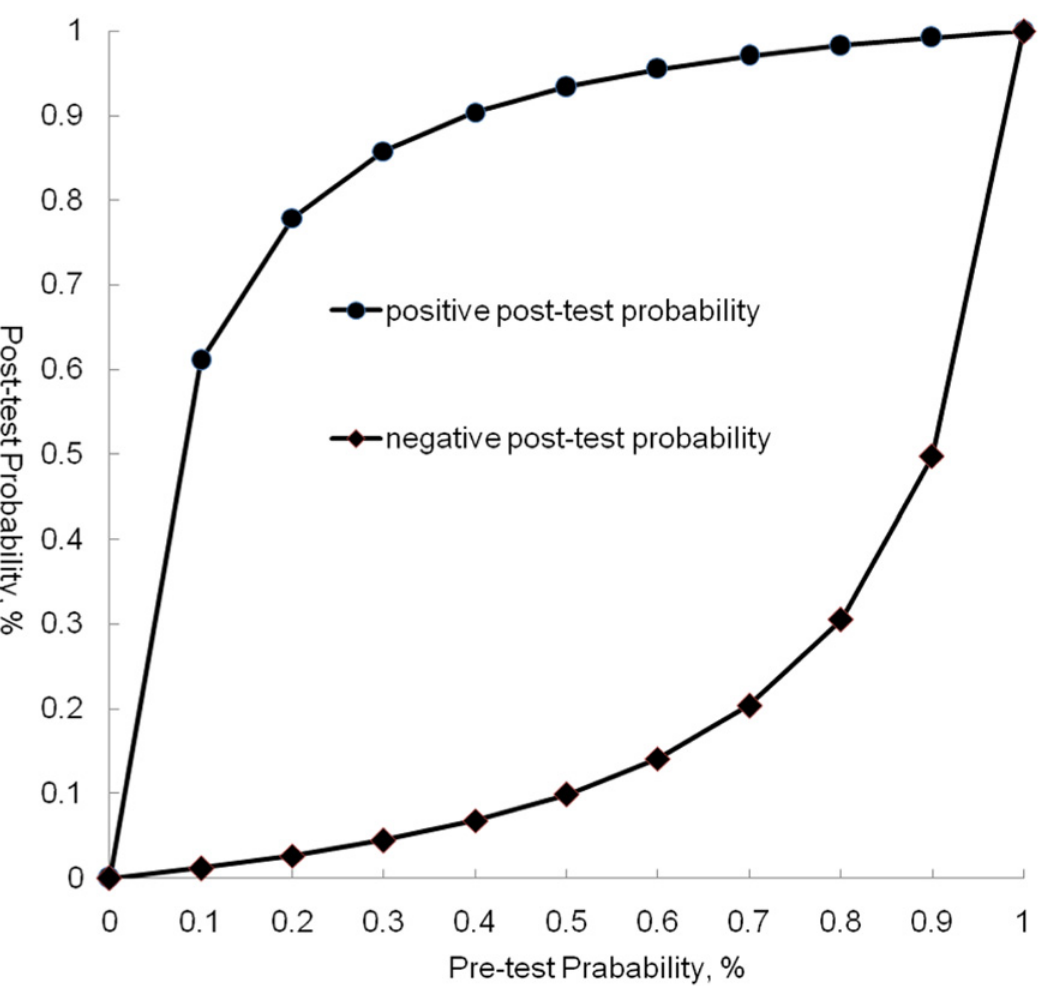
Fig 7. Deek ’ s test to measure the funnel plot asymmetric. P-values less than 0.05 were considered representative of publication bias. (A) patient basis; (B) total